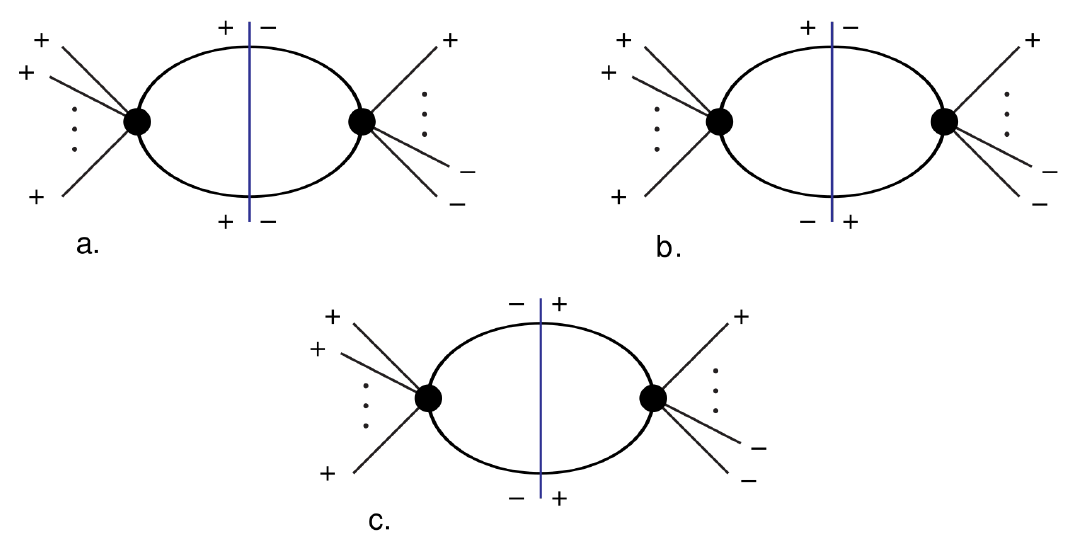
Figure 2: The three types of cut which reproduce the N = 4